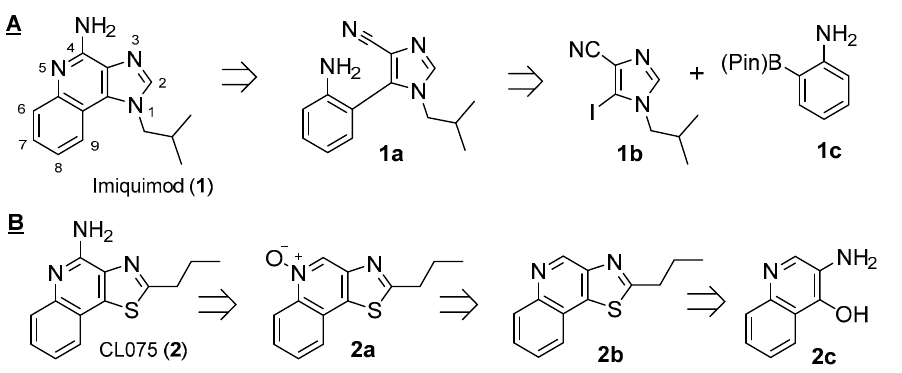
Figure 1. Synthetic strategies to arrive at the 4-amino imidazoquinolines ( A ) and thiazoloquinolines ( B ).